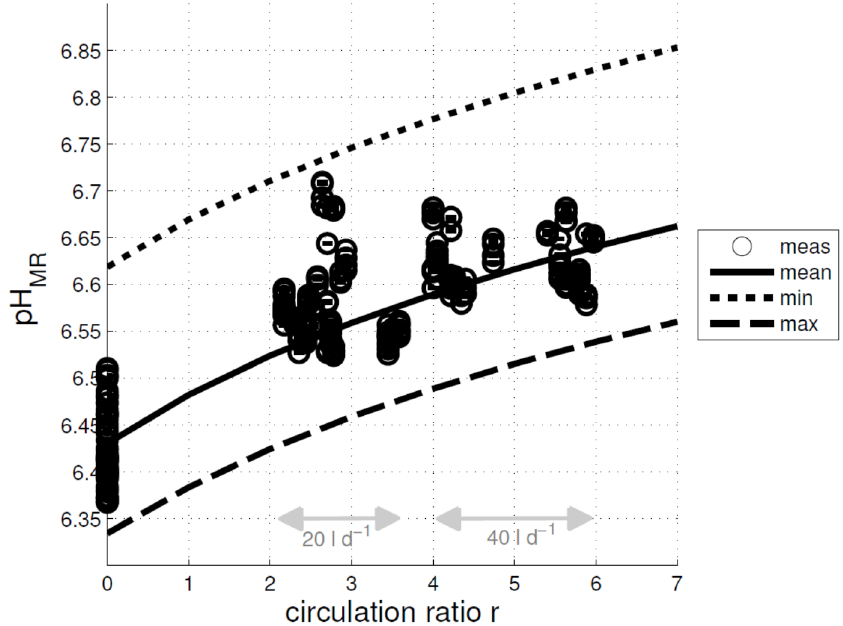
Figure 4. The pH value of the pressurized anaerobic filter at different circulation